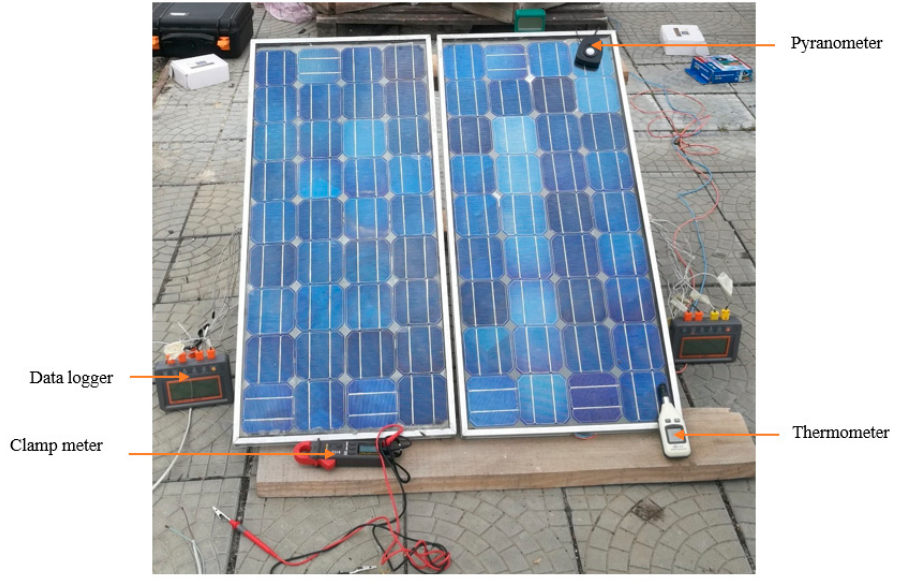
Figure 1. Experimental setup.